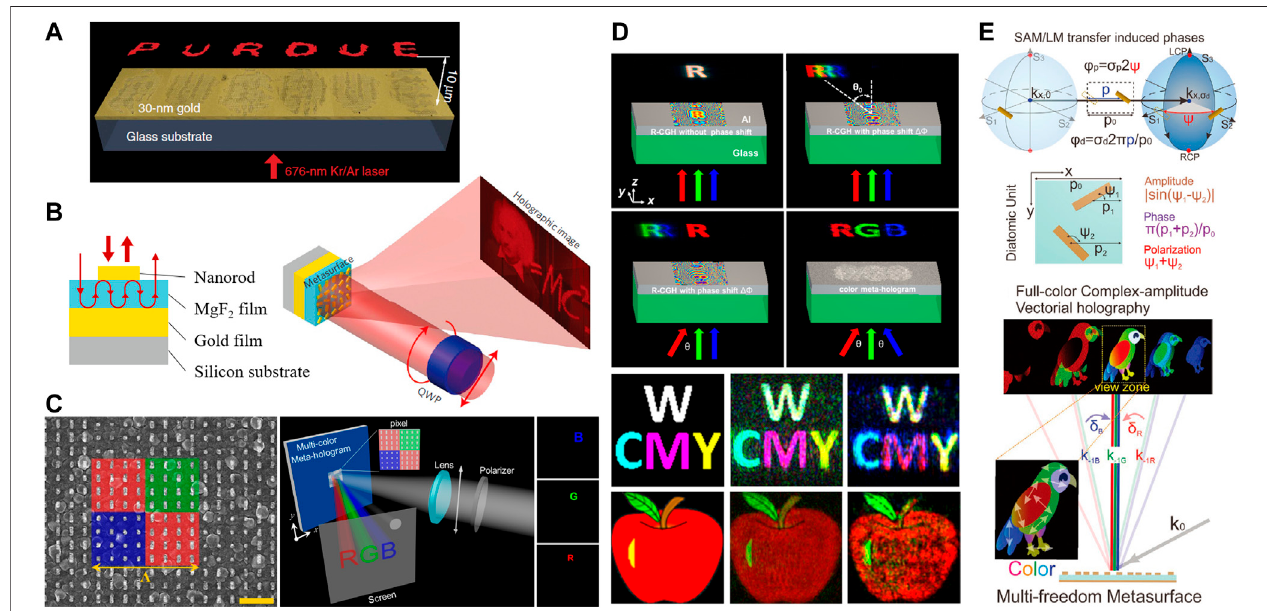
FIGURE4|(A) ComplementaryV-shapedmetallicgroovesproduceasingle-colorholographicimageoftheword “ PURDUE ” [113]. (B) Metasurfacehologramwith Metal-Insulator-Metal (MIM) structure design for improving the ef fi ciency and shows an Einstein ’ s portrait [193]. (C) Metasurface with super meta-atoms composed of multi-resonators designed for RGB three-primary colors and demonstrates three-colors metasurface hologram [60]. (D) Metasurface hologram withoff-axis illumination methodrealizesthedecodingofthreeprimarycolorcomponents,andfurthergeneratestheirsecondarysuperimposedcolors(suchascyan,magenta,yellow,and white) [145]. (E) Design principle of the multi-freedom metasurfaces for full-color meta-hologram [29]. Figure reproduced with permission from: (A) , © 2013, Nature Publishing Group (NPG); (B) , © 2012, Nature Publishing Group (NPG); (C) , © 2015, American Chemical Society (ACS); (D) , © 2016, American Chemical Society (ACS); (E) , © 2020,